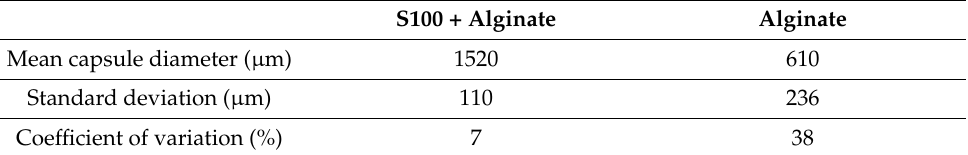
Figure 2. Release kinetics of phages from the core-shell capsules. Capsules were produced using a 200 µ m core nozzle and 400 µ m shell nozzle. The aqueous phase was loaded into a syringe pumping fluid to the shell nozzle and was composed of 10% ( w / v ) S100 and 1% ( w / v ) alginate or a solution of 1% ( w / v ) alginate only. The phage containing water-in-oil emulsion phase was loaded into a syringe pumping this phase to the core nozzle. The emulsion was produced using 10% ( v / v ) T3 phage stock in SM buffer, Miglyol with +5% ( v / v ) added PGPR. ( a ) Release kinetics of S100 + alginate and alginate only shelled capsules, 0.1 g of capsules were dissolved in 1 mL of Sorensen’s buffer (pH 7.5) and incubated for 2 h at 37 ◦ C. At each time point, a sample was taken for phage enumeration using the plaque assay. Error bars represent one standard deviation. ( b ) Final core-shell particles after alginate crosslinking and polymer protonation, captured using a Nikon D7700 and a macro lens (Sigma 105 mm F2.8). ( c ) Phage release from alginate capsules in different pH buffers. 0.1 g of alginate only shelled capsules were incubated in 1ml of each buffer (Sorensen’s buffer) for 2 h, final phage titres were confirmed using the plaque assay.* Significant differences in phage titres (n = 4) using a paired t -test at each pH value compared to pH 7.5 ( p > 0.05). Table 1. Table outlining size characteristics of alginate only capsules. ImageJ was used for S100 + alginate capsules (n = 20). Laser diffraction was used for alginate only capsules. Error bars represent one standard